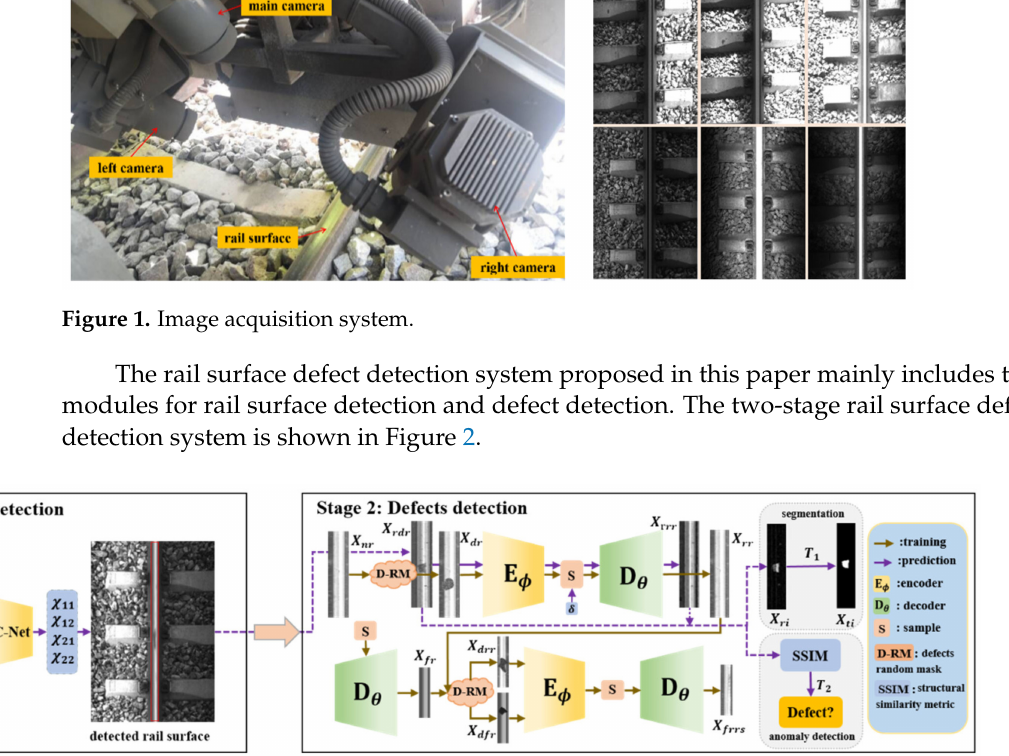
Figure 2. Two-stage rail surface defect detection